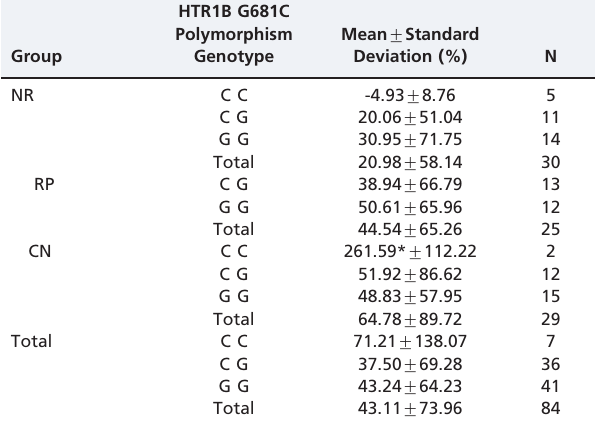
Table 5 - A comparison of the cortisol maximal percent of variation among the eight subgroups based on the three groups of subjects and the HTR1B G681C polymorphism